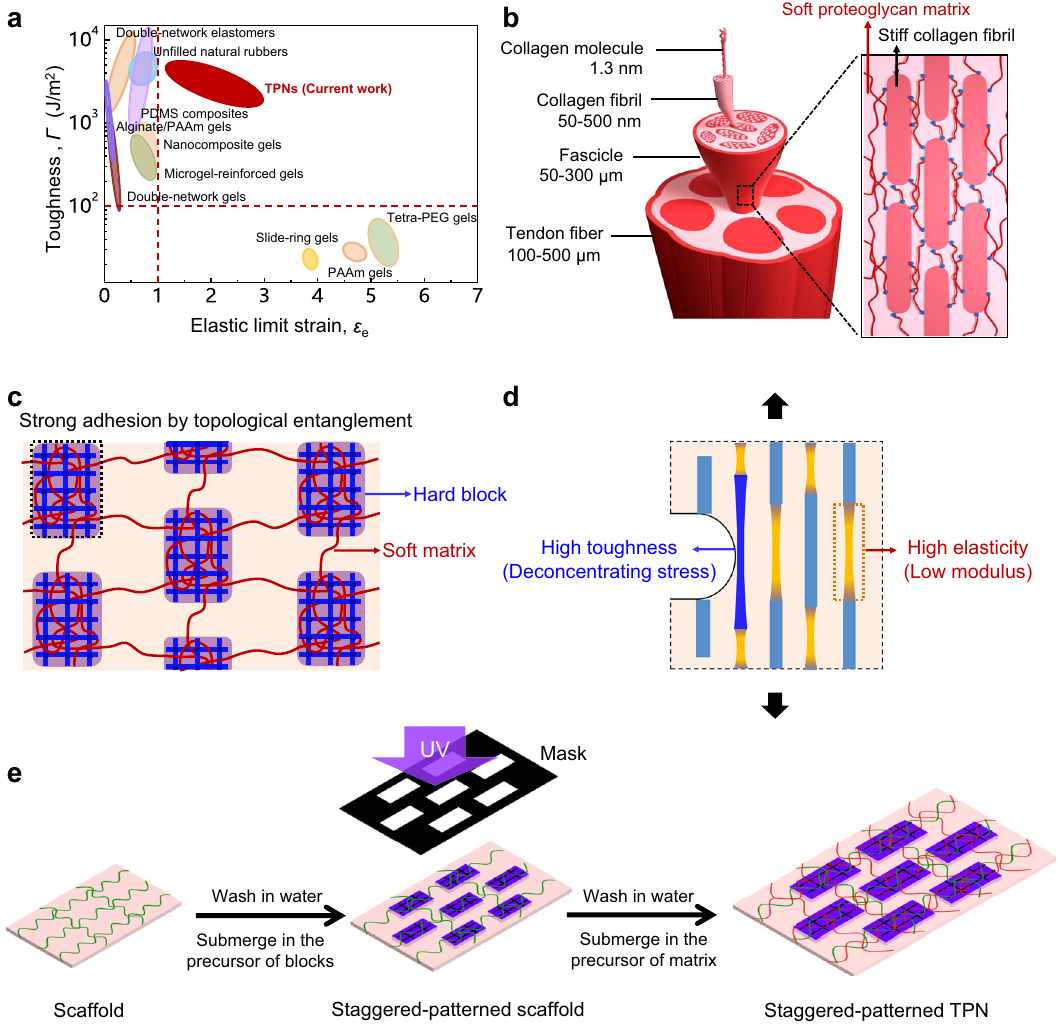
Fig. 1 Topoarchitected polymer networks (TPNs). a Existing elastomers and hydrogels (equilibrium-swollen in water) exhibit a negative correlation between two properties: elastic limit strain and toughness. The TPNs synthesized in this work simultaneously achieve high elastic limit strain and high toughness. b In a fascicle of an Achilles tendon, staggered collagen fi brils are embedded in a proteoglycan matrix. c Schematic illustration of TPNs. Hard blocks adhere to a soft matrix through topological entanglement of polymer networks. d Mechanical principle of a staggered-patterned TPN for high elasticity and high toughness. e TPN hydrogels prepared by sequential polymerization and